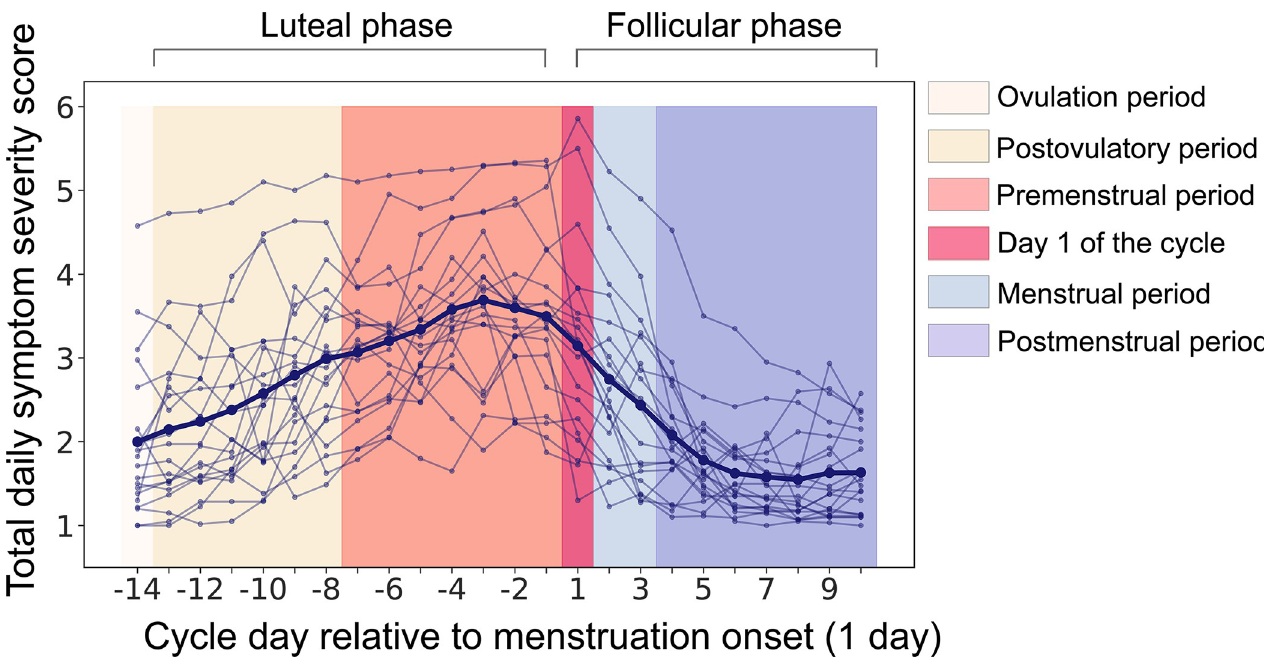
Fig 2. Daily symptom severity scores (from 1 = ‘Not at all’ to 6 = ‘Extreme’) averaged over 20 symptoms (C-PASS questionnaire [88]) and two or three menstrual cycles in participants with PMDD. The thin lines show individual participants; the thick line is the group average. The days are numbered relative to the start of menstruation (day